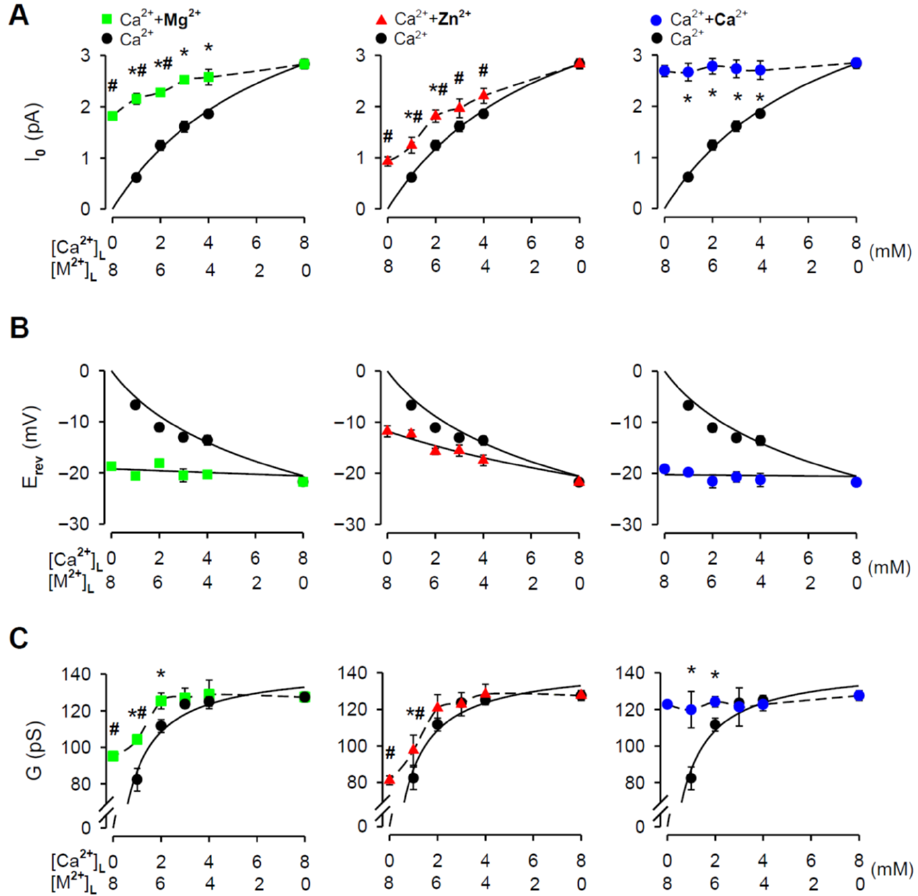
Figure 3. M 2+ /Ca 2+ mole-fraction experiments under non-saturating conditions. The I 0 ( A ), E rev ( B ), and G ( C ) plotted against a composition of M 2+ /Ca 2+ mixture on the RYR2 luminal face (M 2+ : Mg 2+ –green square, Zn 2+ –red triangle, or Ca 2+ –blue circle). In total, 4, 5, 6, 7 mM [M 2+ ] L was added to 4, 3, 2, 1 mM [Ca 2+ ] L , respectively, to keep the total divalent concentration constant at 8 mM. Data obtained for pure 8 mM [M 2+ ] L are also included. As the control, the [Ca 2+ ] L -dependence of E rev , G and I 0 is shown (black circle). * Significantly different from the respective control values; # significantly different from the control value obtained for 8 mM [Ca 2+ ] L (two-way ANOVA with Tukey’s post hoc test). The solid lines in ( B ) are the best fits using Equation (1) and in ( A ) and ( C ) using the Michaelis—Menten equation. The dashed lines in ( A ) and ( C ) are drawn point to point. Data shown are average ± SEM of 5–15 experiments and error bars are shown only when SEM is larger than symbol size.